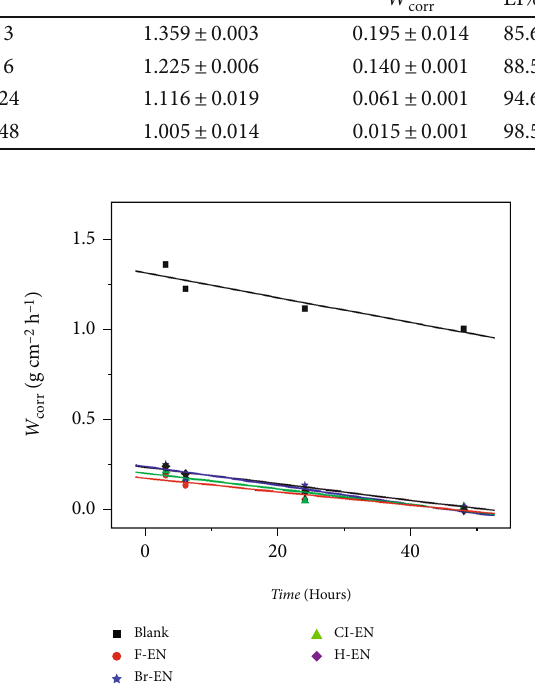
Figure 6: Graphic of W corr versus immersion time for the halogenated enaminoesters synthesized against AISI 1020 carbon steel in 1.0mol L -1 HCl solution in the absence and in the presence of